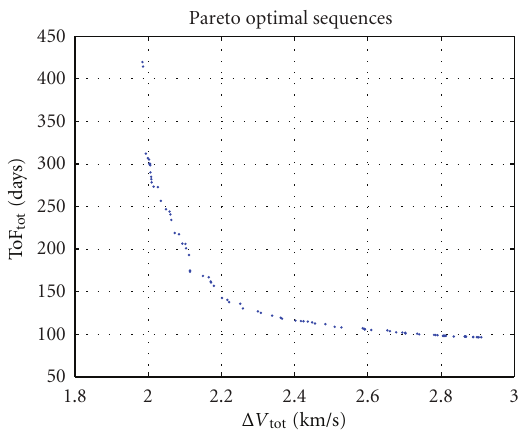
Figure 16: Global Pareto front.